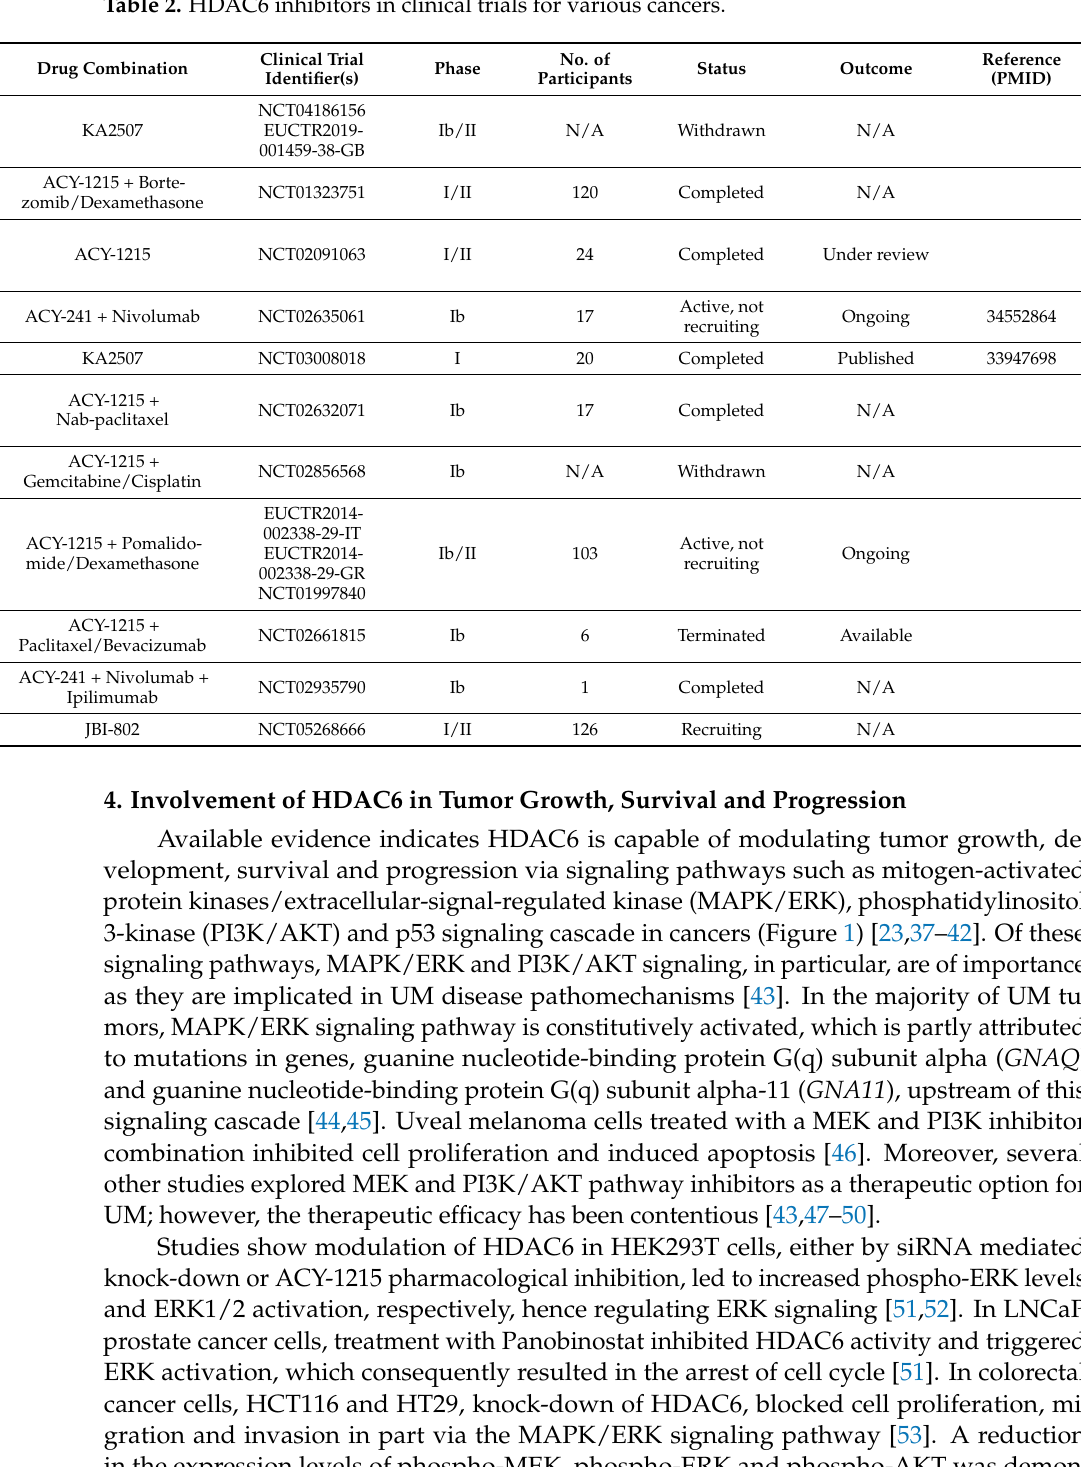
Table 2. HDAC6 inhibitors in clinical trials for various